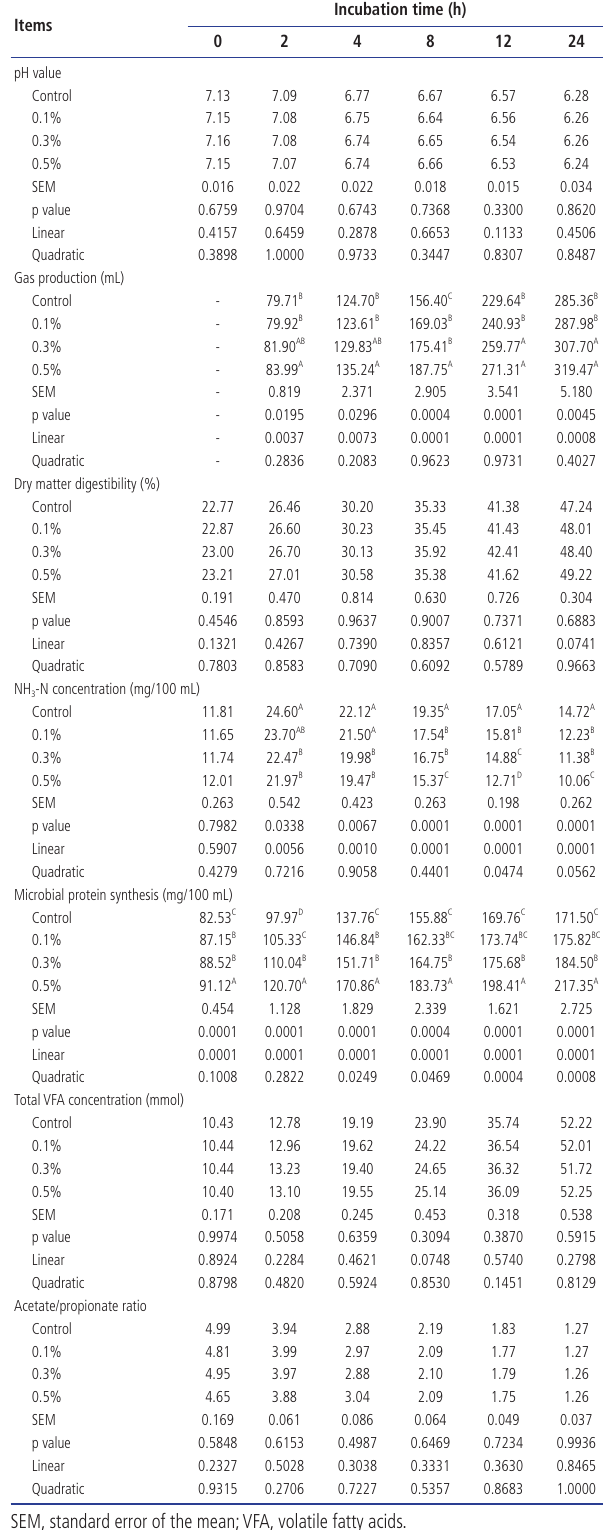
Incubation time